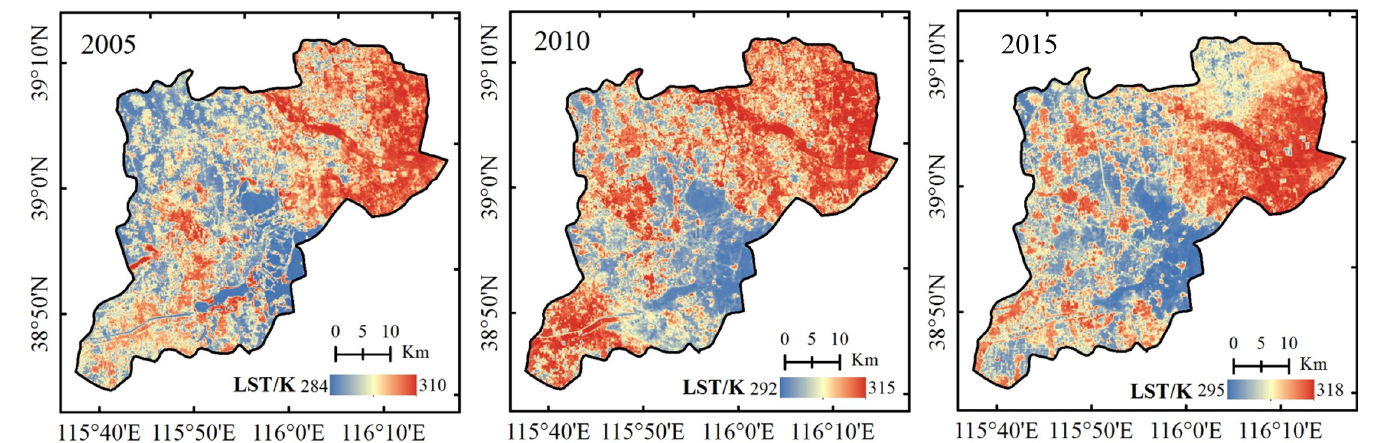
Fig 5. Distribution of land surface temperature in the Xiongan New Area in 2005, 2010 and 2015.